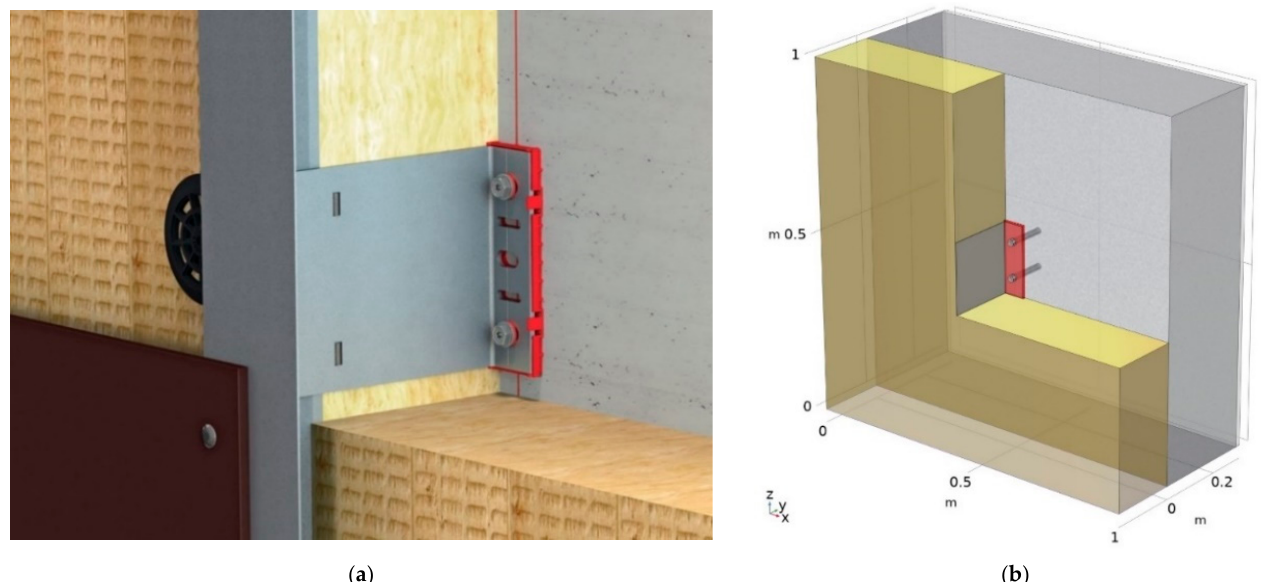
Figure 2. ( a ) Ventilated façade construction with large aluminium brackets using thermal break [15], ( b ) parametric geometry model of concrete wall with a large aluminium bracket and thermal break created in Comsol used for the numerical modelling.